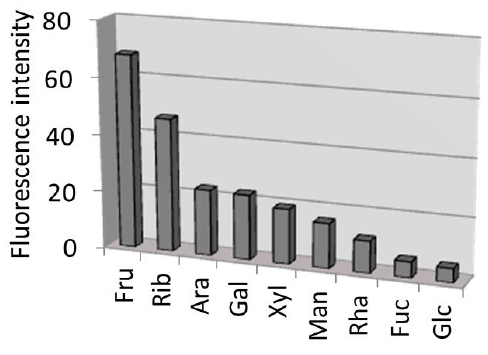
Figure 3. Fluorescence enhancement of SQ-BA with various